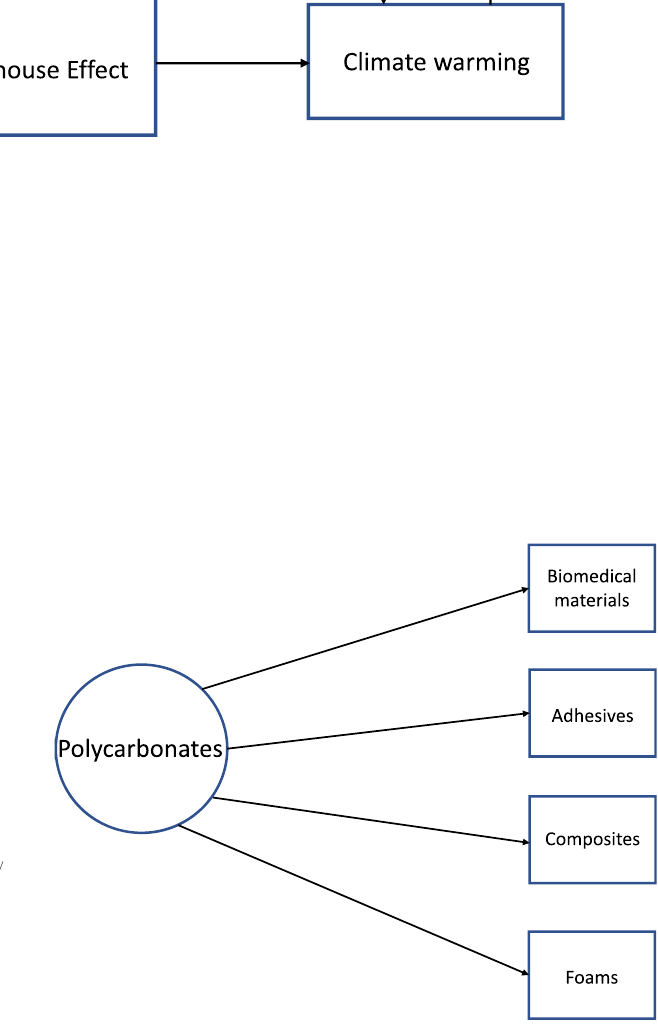
Fig. 3. Examples of applications of